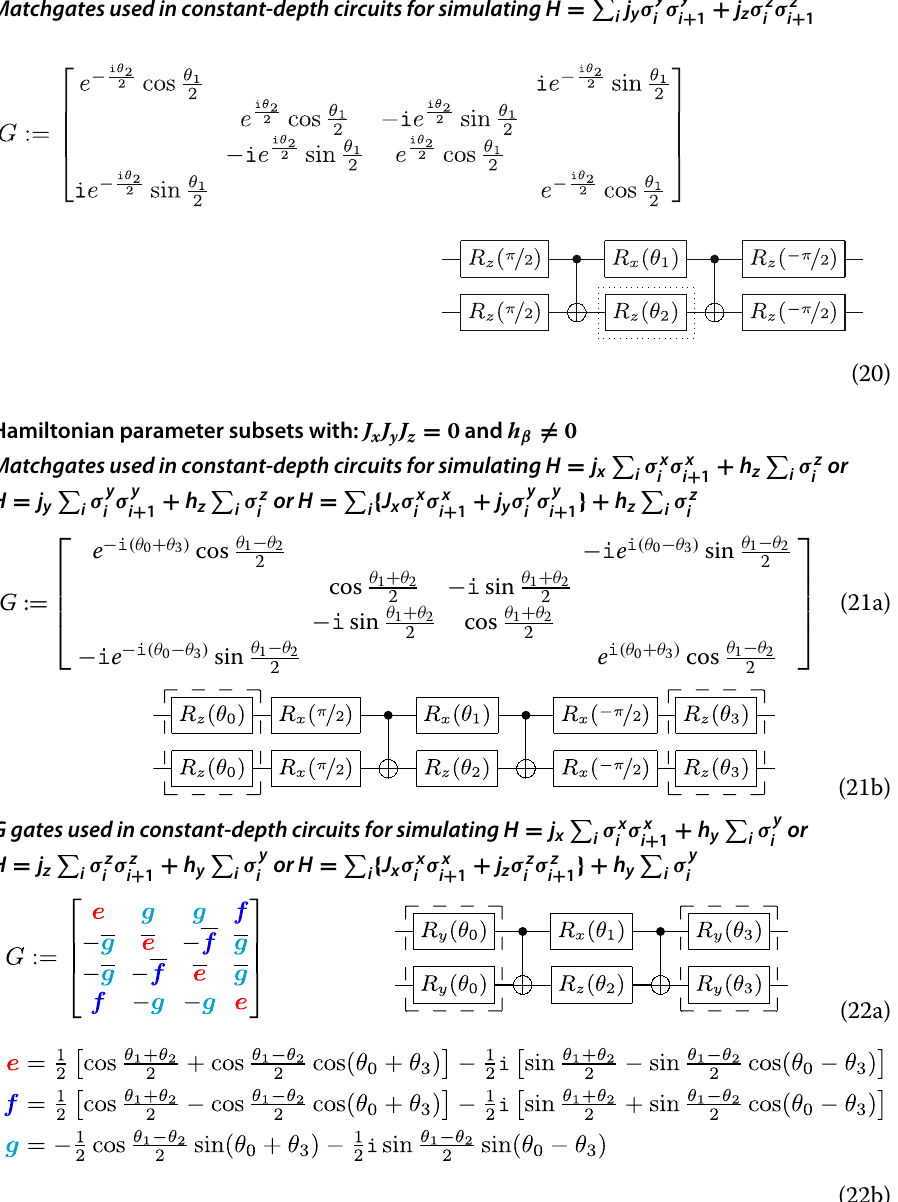
G gates used in constant-depth circuits for simulating H = j x